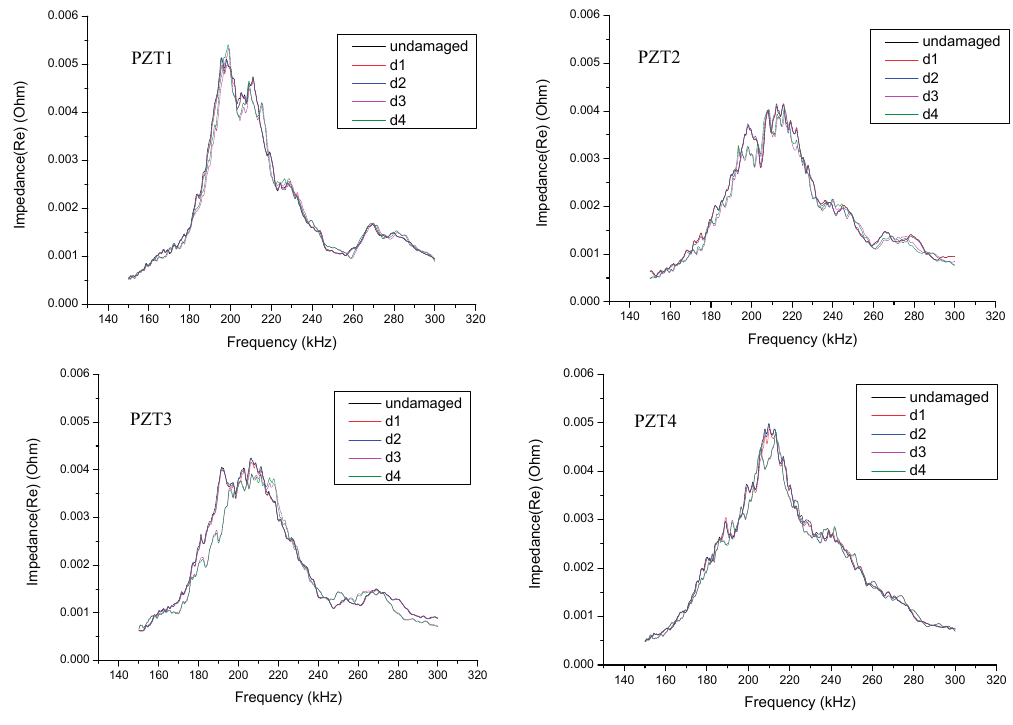
Figure 5. Real part of the undamaged and damaged impedance curves for PZT1–PZT4 (frequency 150–300 kHz).